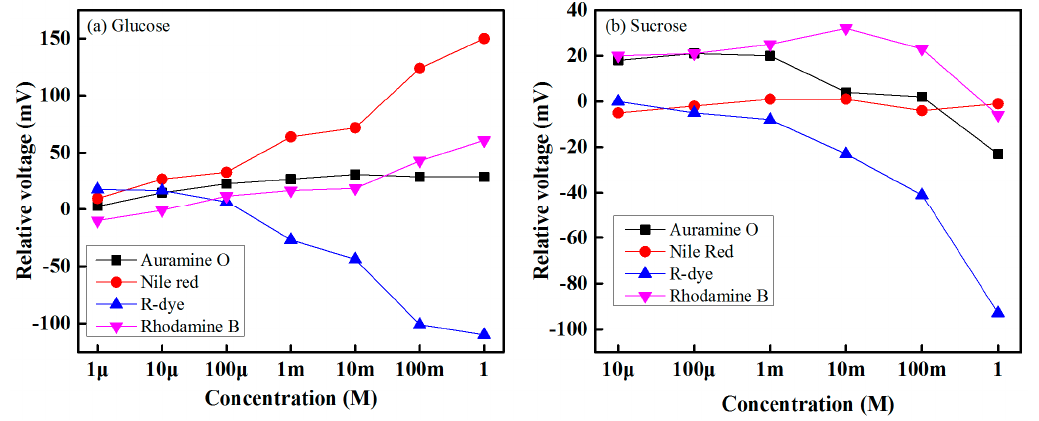
Figure 7. Response of the different sensing elements under: ( a ) glucose solution; and ( b ) sucrose solution.